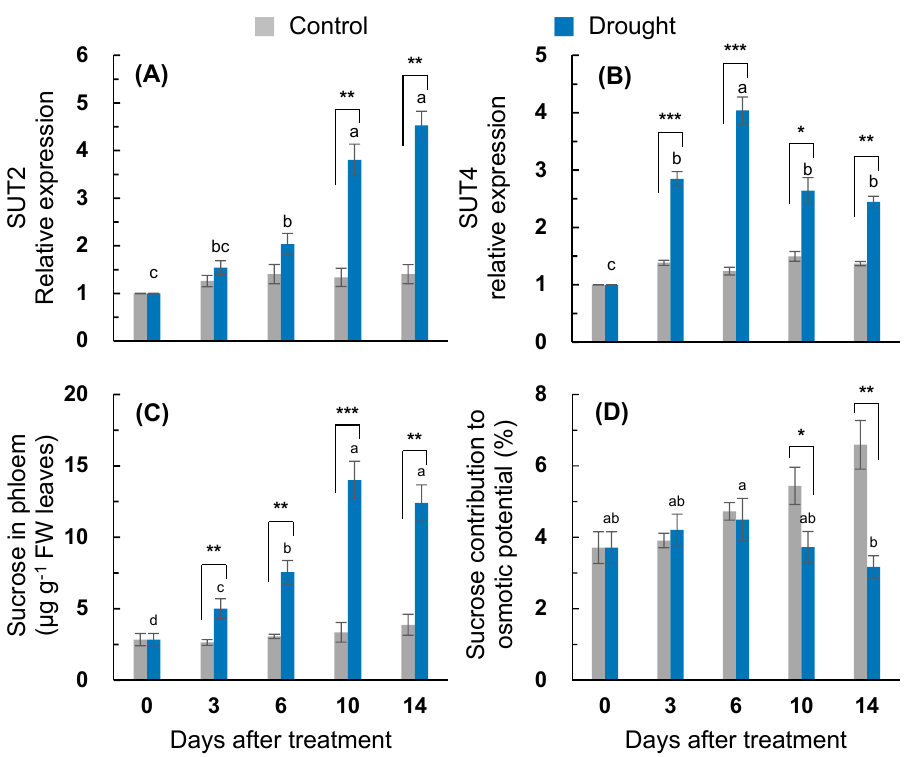
Figure 6. Changes in the relative gene expression of sucrose transporters ( A ) SUT2 and ( B ) SUT4 , ( C ) sucrose content in the phloem exudate, and ( D ) contribution percentage of the sucrose-to-osmotic potential in the leaves of the well-watered control or drought-stressed plants during 14 days of treatment. Data are presented as the mean ± SE from duplicates for each of the four independent plants. Bars labeled with different letters in the drought-stressed plants are significantly different at p < 0.05, according to Duncan’s multiple range test. Asterisks denote a statistical difference between the drought treatment and control: * p < 0.05, ** p < 0.01, and *** p < 0.001.